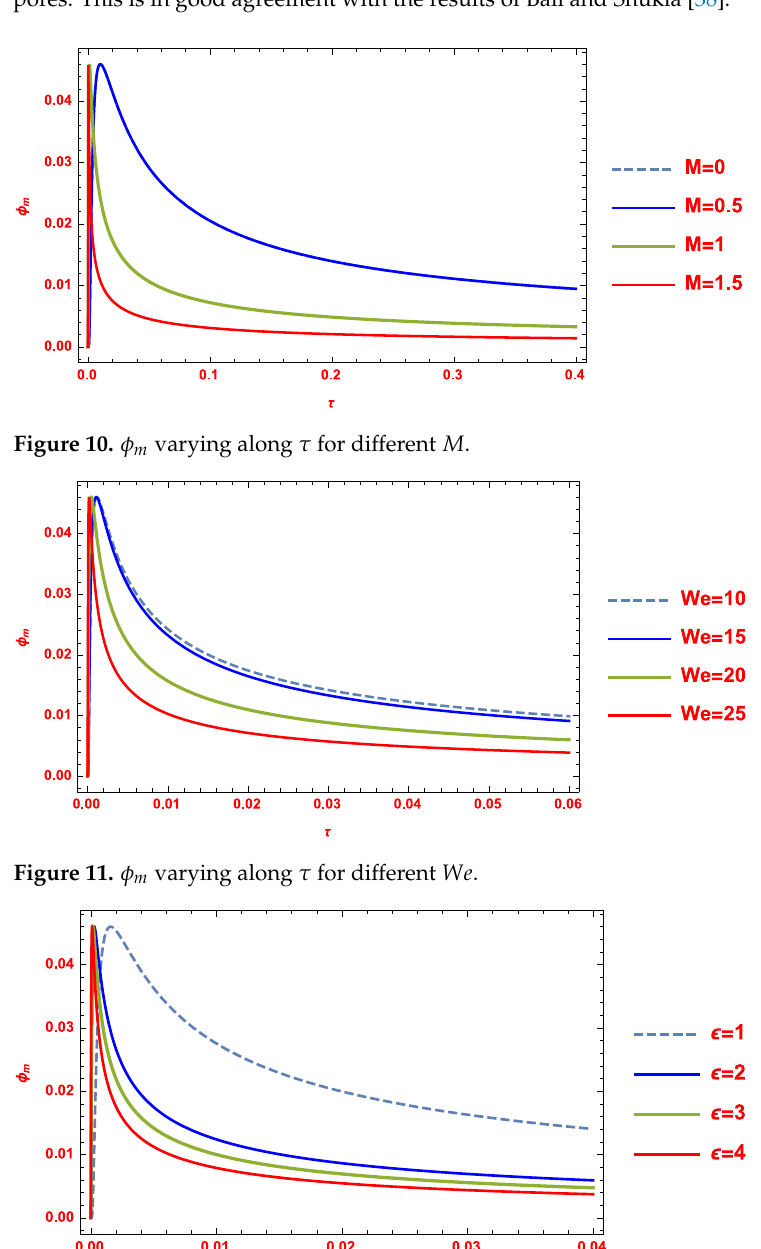
Figure 12. φ m varying along τ for different (cid:101)